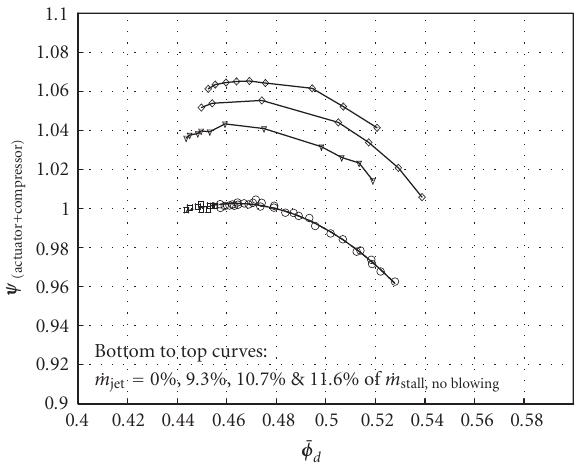
Bottom to top curves: